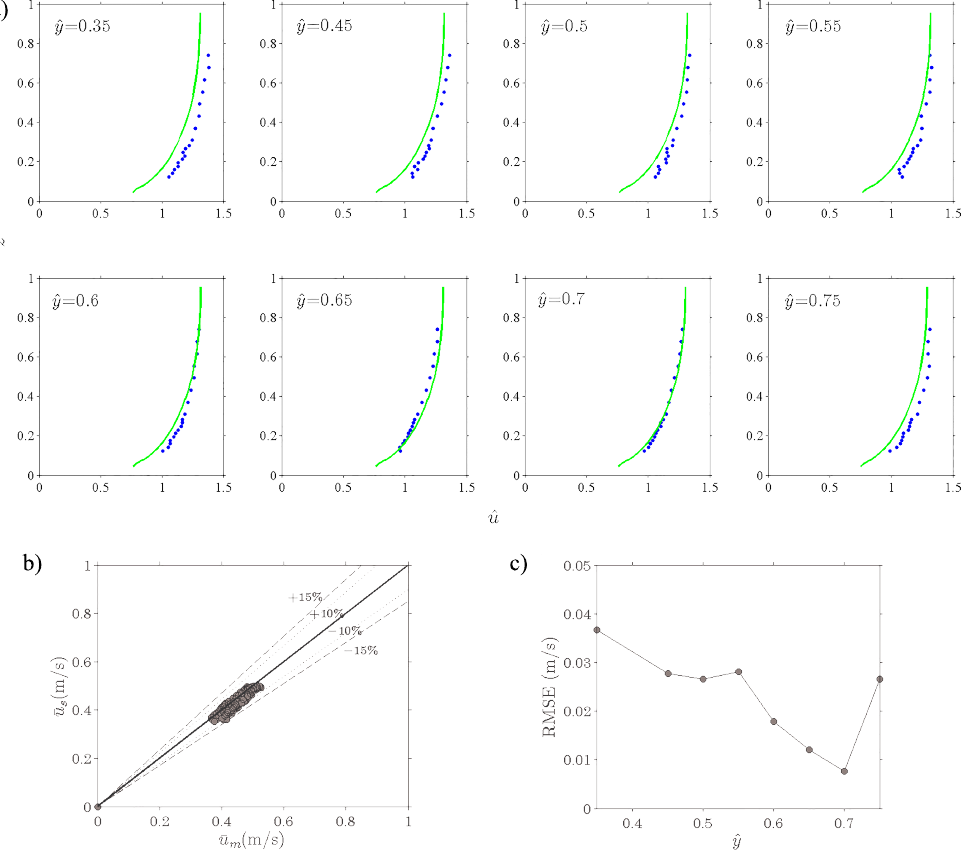
Figure 7. ( a ) comparison of measured (blue dots) and simulated (green lines) non-dimensional streamwise velocity component profiles in cross-section no. 1; ( b ) comparison of measured and simulated streamwise velocity components; ( c ) Root Mean Square Error (RMSE) of the streamwise velocity component profiles from ˆ y = 0.35 to ˆ y = 0.75 in cross-section no.